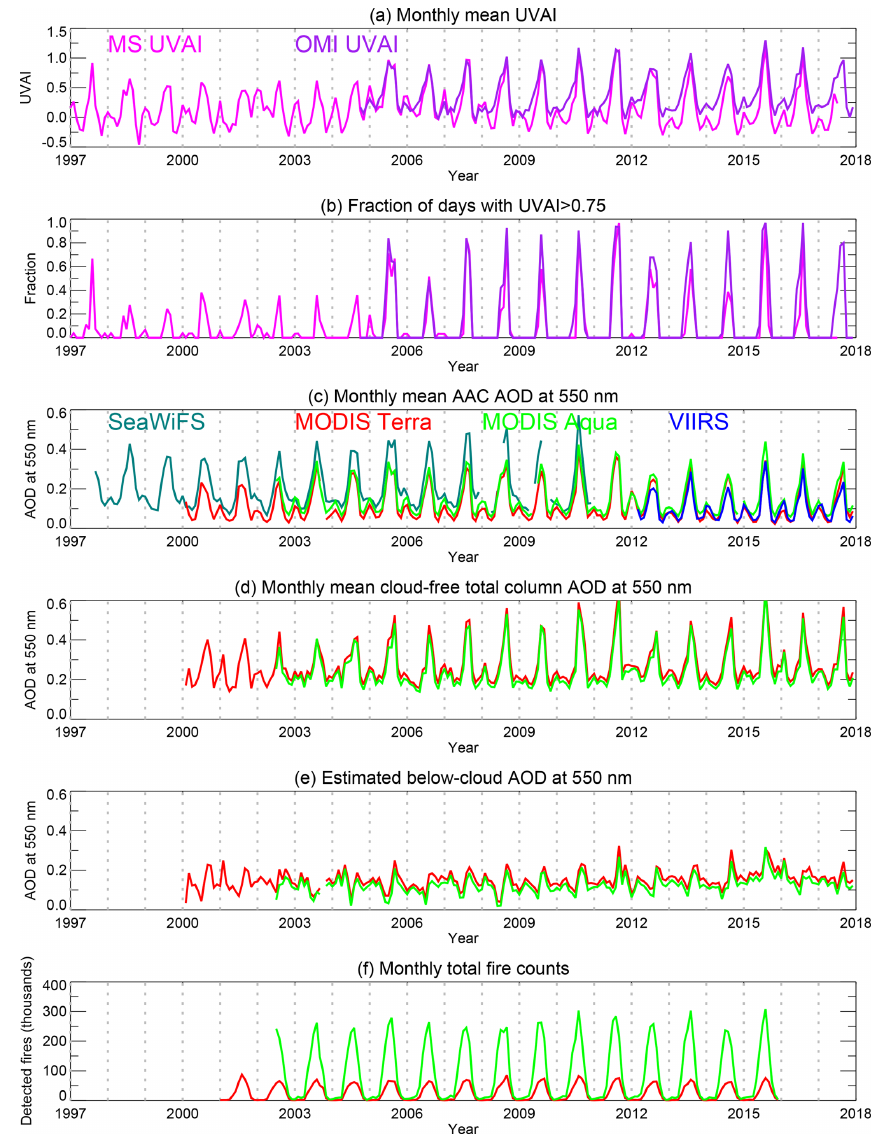
Figure 13. Monthly time series of various satellite data sets over the green box (25 ◦ S–0 ◦ N, 15 ◦ W–15 ◦ E) in Fig. 2. Panel (a) shows the monthly mean UVAI from the multi-sensor (MS) and OMI data sets, and (b) shows the fraction of days in each data set where the box- averaged UVAI is over 0.75. Panel (c) shows the mean AAC 550nm AOD using the algorithm presented in this work, applied to SeaWiFS, MODIS Terra/Aqua, and VIIRS measurements. Panel (d) is a time series of monthly mean total column (cloud-free) over-water 550nm AOD from the MODIS Terra/Aqua DT data sets. Panel (e) is the difference between total column and above-cloud AOD (i.e. d – c ), estimated for MODIS Terra and Aqua. Panel (f) shows monthly total corrected fire counts from MODIS Terra and Aqua (box shifted 25 ◦ E from the others). Throughout, MS data are shown in magenta, OMI in purple, SeaWiFS in teal, MODIS Terra in red, MODIS Aqua in green, and VIIRS in blue. Months with fewer than three contributing days are